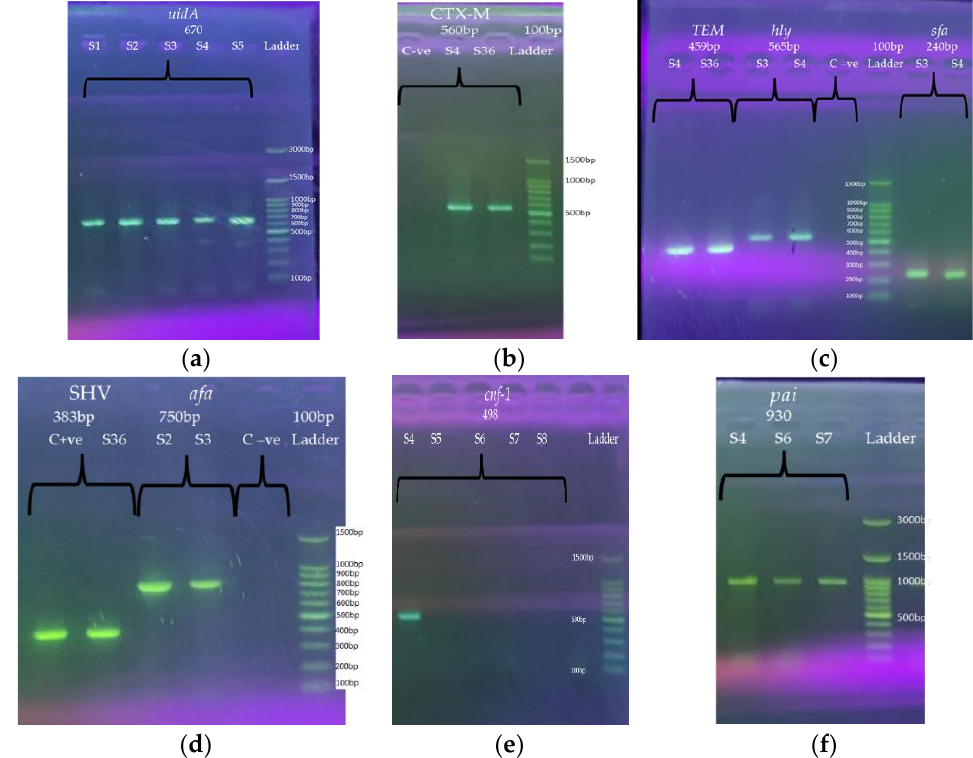
Figure 1. Gel electrophoresis of PCR products for E. coli -specific primers uidA ( a ) marker genes ( bla TEM , bla CTX-M , and bla SHV ) ( b – d ) and five virulence factors marker genes ( pai, hly, cnf-1, sfa and afa ) ( c – f ). The amplified DNA fragments produce of various E. coli strains with these marker primers: species-specific primer uidA (lanes 1–5 for strains 1–5) ( a ), CTX-M (lanes 1, 2 and 3 for control negative and strains 4 and 36, respectively) ( b ), TEM (lanes 1 and 2 for strains 4 and 36), hly (lanes 3 and 4 for strains 3 and 4 and lane 5 for control negative), and sfa (lanes 7 and 8, for strains 3 and 4) ( c ), SHV (lanes 1 and 2, for strains control positive and S36), afa (lanes 3 and 4, for strains 2 and 3) ( d ), cnf-1 (lanes 1, 2, 3, 4, 5 and 6 for strains 4, 5, 6, 7, 8 and control-ve) ( e ), and pai (lanes 1, 2, and 3, for strains 4, 6 and 7) ( f ), and lane 100 bp Ladder (GDSBio Marker) ( b – e ) and 300 bp (GeneDireX, Marker) 1.5% agarose gel stained with 5 µL of Safe Gel Stain Dye. Key: pai ; pathogenicity island; hly ; hemo- S = strain.